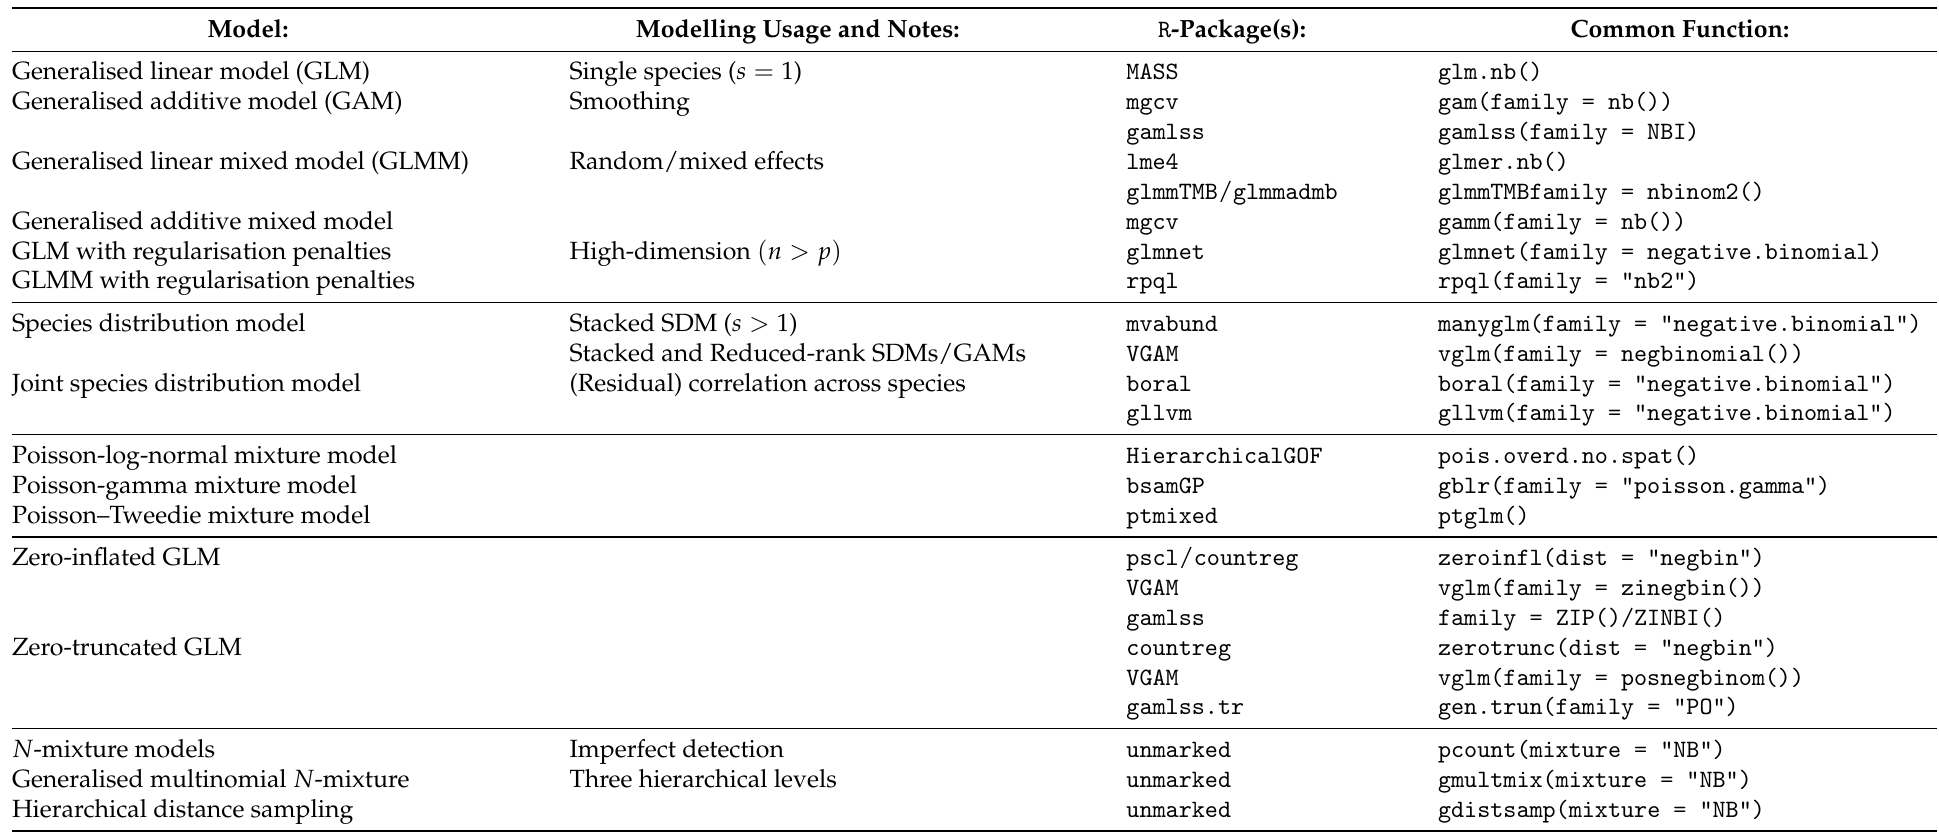
Table 3. A selective list of R -packages for fitting various traditional and modern negative binomial (NB) models described in the main text. We denote as s the number of species/taxa, n the number of sampling units (e.g., sites), and p the number of covariates. Note that generic Bayesian MCMC packages such as the rjags and R2jags R -packages can also be used to fit many of the models listed below, with some additional coding required for specifying the NB likelihood. Indeed, some of the modern NB models discussed in Section 3 either do not have currently associated R -packages, or require bespoke R -code. Furthermore, some of the packages listed can fit multiple types of NB models (e.g., the gamlss package can also fit NB GLMs and